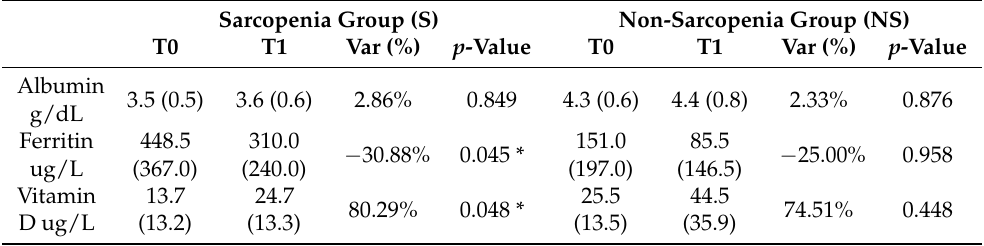
Table 3. Main laboratory findings at T0 and T1 in the sarcopenia group (S) and the non-sarcopenia group (NS). All data are reported as mean ± standard deviation